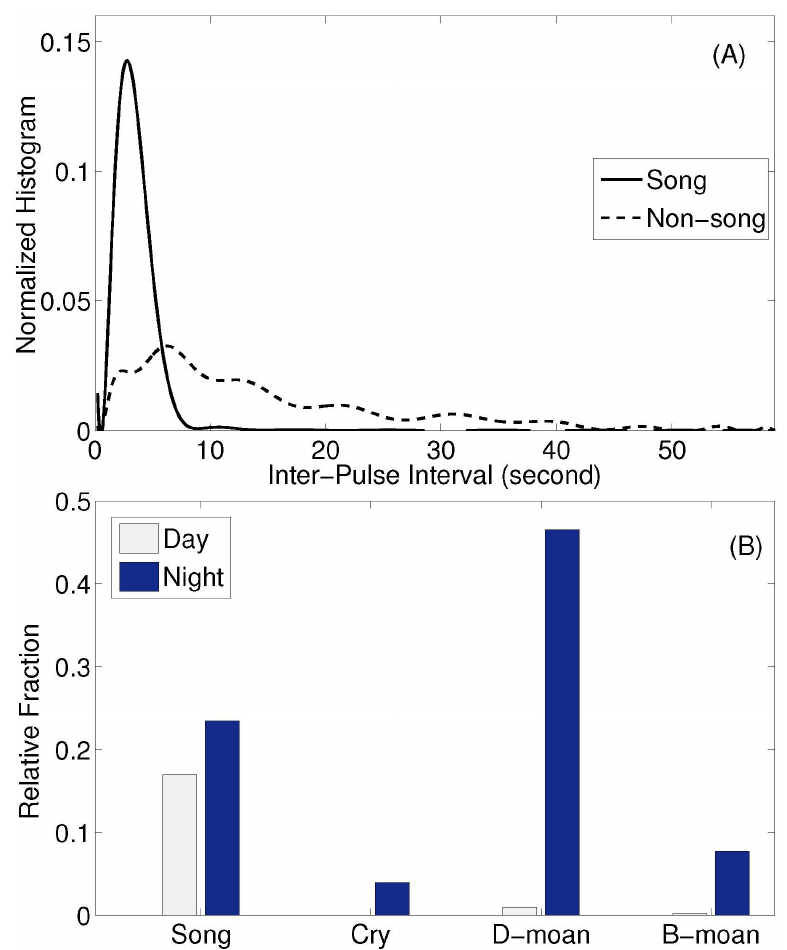
Figure 5. ( A ) Normalized histogram of inter-pulse intervals for humpback song and non-song vocalizations. The mean inter-pulse interval for songs is 3.5 s with standard deviation of 1.8 s. The mean inter-pulse interval for non-song vocalizations is 14.2 s with standard deviation of 11 s; ( B ) Percentage occurrence of humpback song and non-song D-moan, B-moan and cry vocalizations. Songs were detected roughly 40% during the day and 60% during the night. The humpback non-song vocalizations were detected at night with negligibly small detections during the